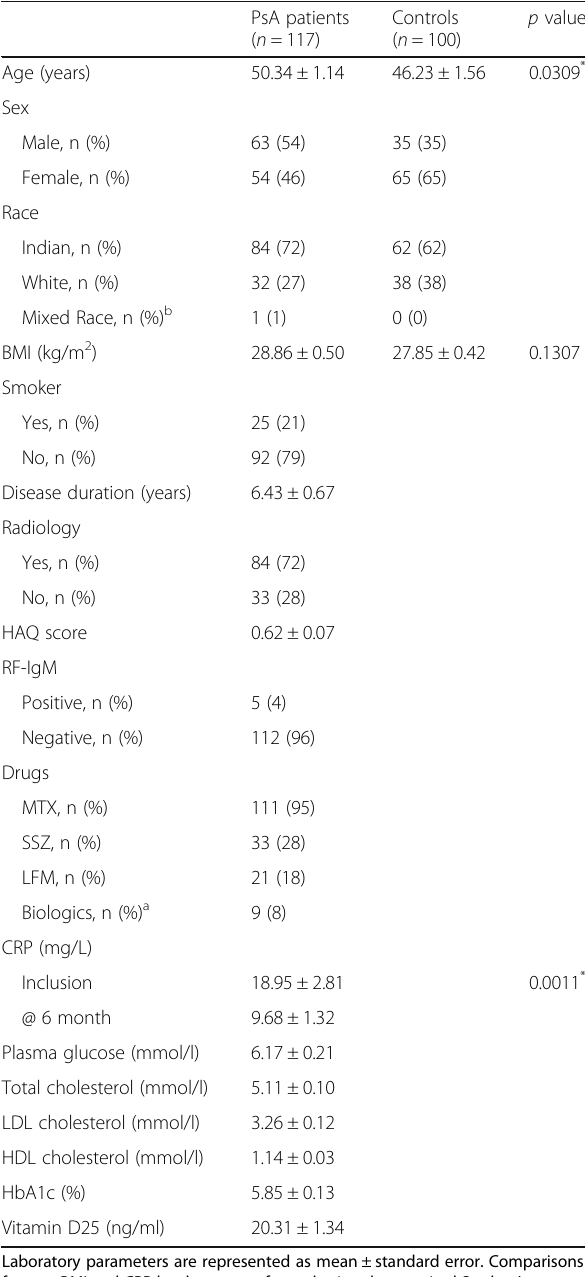
Table 1 Clinical and demographical characteristics of PsA patients and